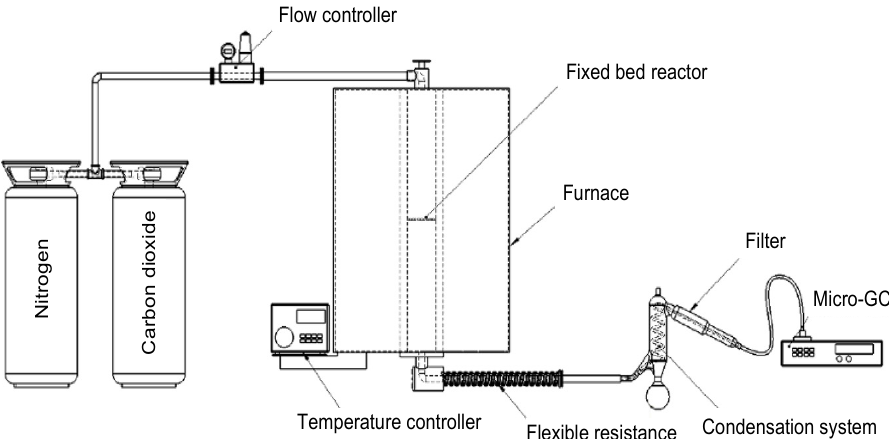
Figure 1. Illustration of the pyrolysis reactor unit, consisting of a fixed bed reactor followed by a condensation system at 0 °C and a micro-GC for gas characterization.